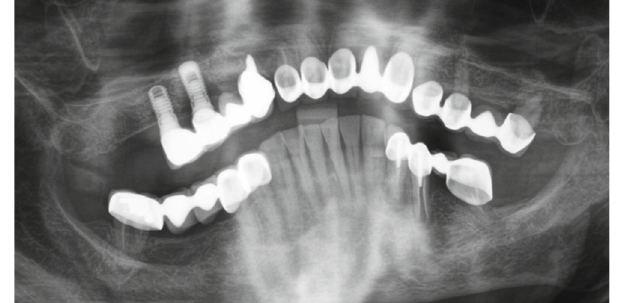
Figure 2: DPT section at intake August